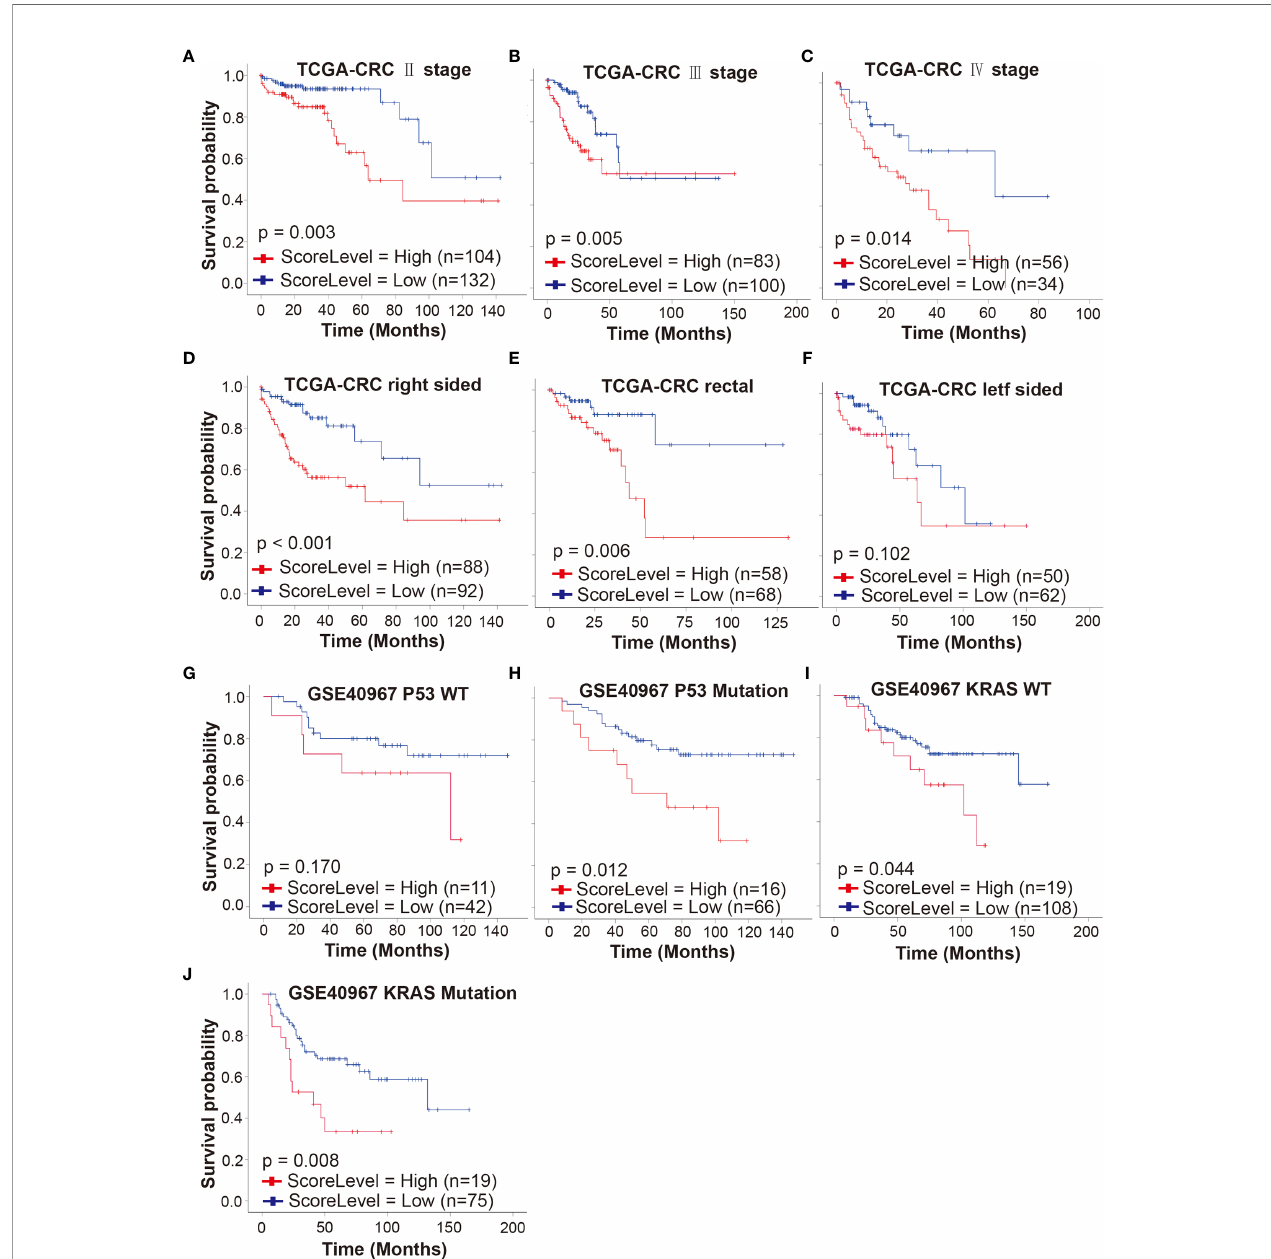
FIGURE 7 | Predictive value of DRSM in CRCpt subgroups. (A – C) Univariate analysis for DRS (high or low) and its correlation with clinical outcomes (OS) of stage II, stage III, and stage IV CRCpts in TCGA-CRC cohort, respectively. (D – F) Univariate analysis for DRS (high or low) and its correlation with clinical outcomes (OS) of right-sided, rectal, and left-sided CRCpts in TCGA-CRC cohort, respectively. (G, H) Univariate analysis for DRS (high or low) and its correlation with clinical outcomes (OS) of CRCpts with wild-type and mutated P53 in GSE40967 cohort, respectively. (I, J) Univariate analysis for DRS (high or low) and its correlation with clinical outcomes (OS) of CRCpts with wild-type and mutated KRAS in GSE40967 cohort, respectively. TCGA, the cancer genome atlas; CRC, colorectal cancer; GSE, gene expression omnibus series; WT, wild type; DRSM, drug-resistant score model; CRCpts, colorectal cancer patients; DRS, drug resistant score; OS, overall